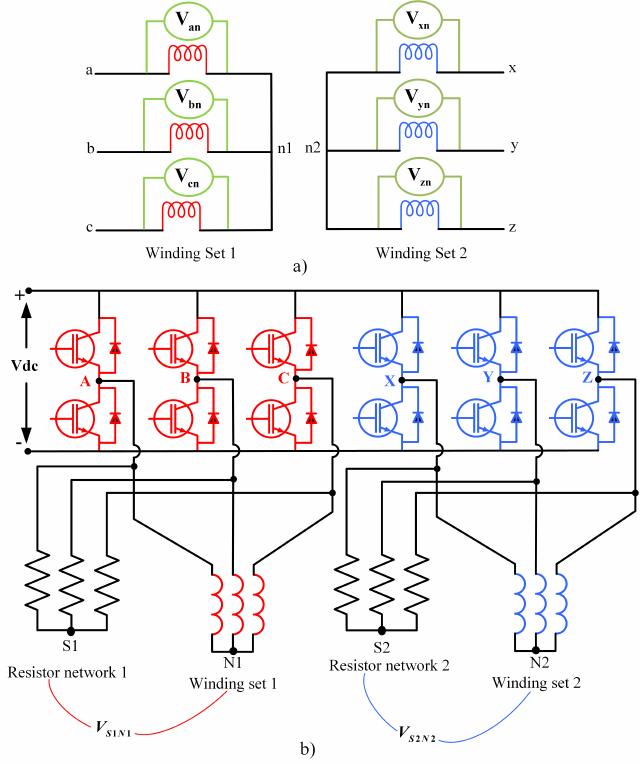
Figure 14. ( a ) Measurement of zero-sequence voltage using phase-to-neutral voltages. ( b ) Measure- ment of zero-sequence voltage using auxiliary resistor network